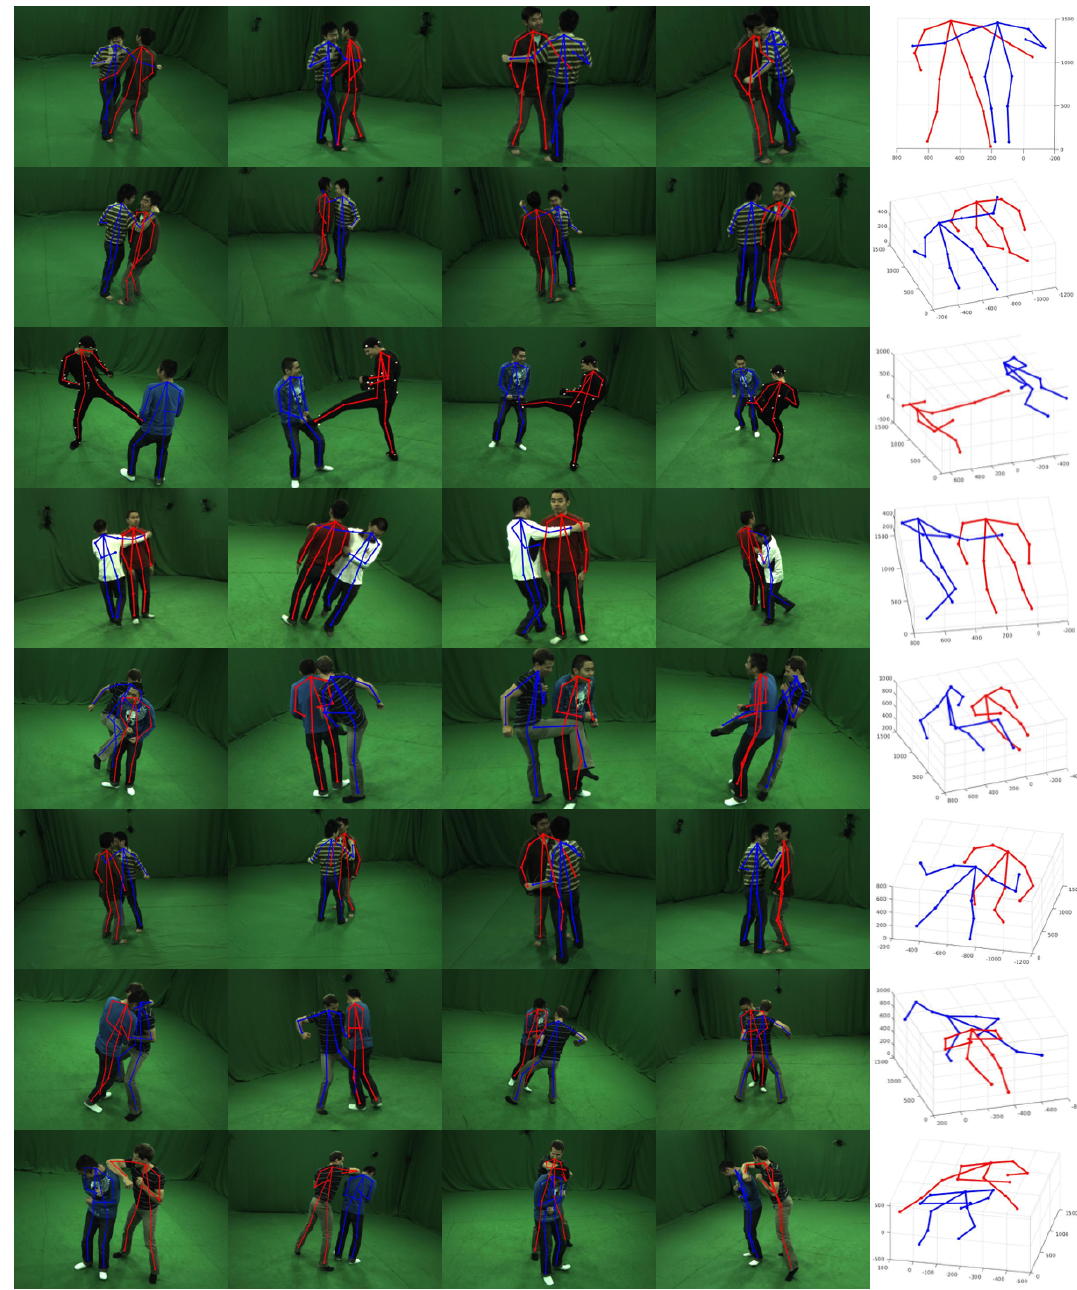
Figure 6. 3D pose detection results on MHHI datasets. The first four columns are the 2D pose results reprojected from 3D pose result. The last column is the 3D pose estimation result of our